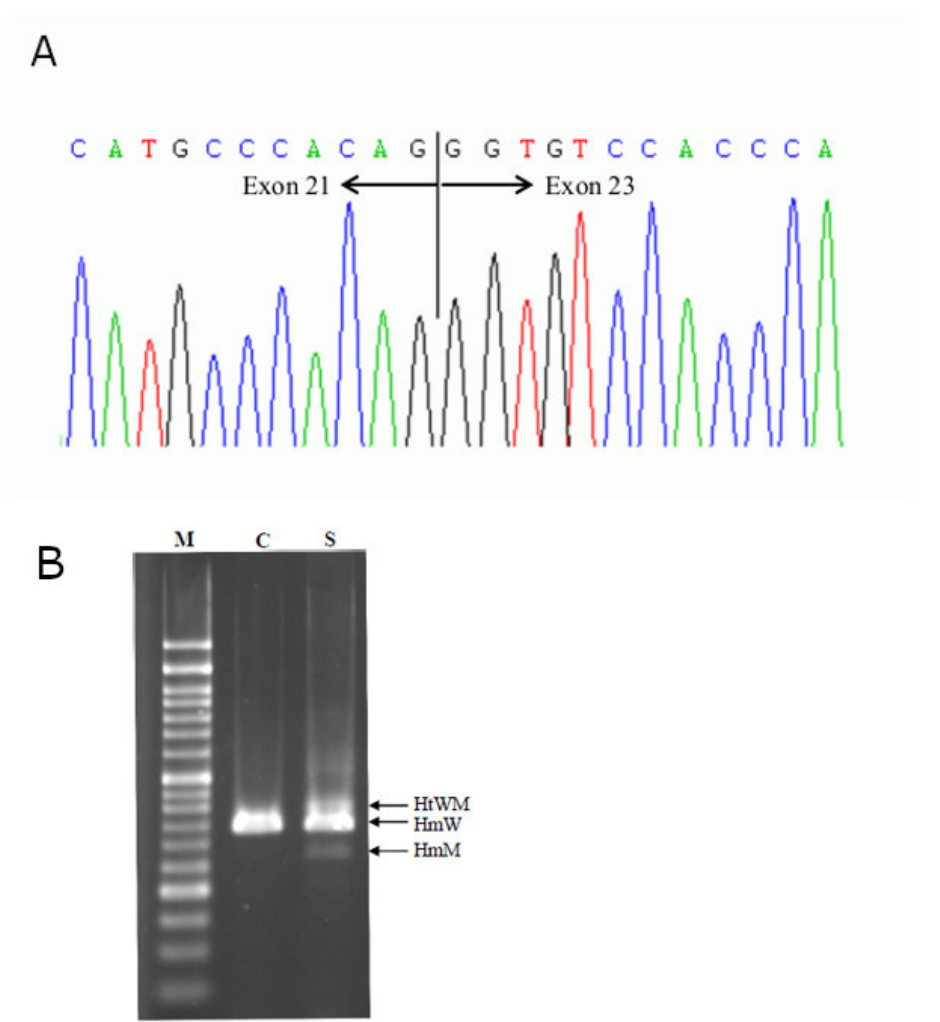
Figure 1. ( A ) Electropherogram showing that deletion of exon 22 on BRCA1 c.5406+7A>G splicing. Deletion was detected by cDNA sequencing, ( B ) Gel electropherogram showing that deletion of 74bp by RT-PCR on BRCA1 c.5406+7A>G. Lane M: 50-bp DNA ladder marker; lane C: Normal human cDNA control; lane S: Proband’s cDNA. HtNM: Heteroduplexes of wild-type and mutant; HmW: Homoduplexes of wild-type; HmM: Homoduplexes of